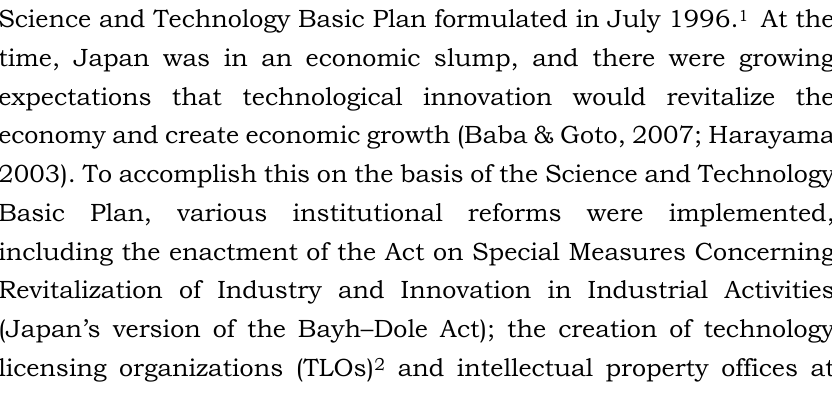
Table 1. Major legal reforms vis-à-vis university–industry